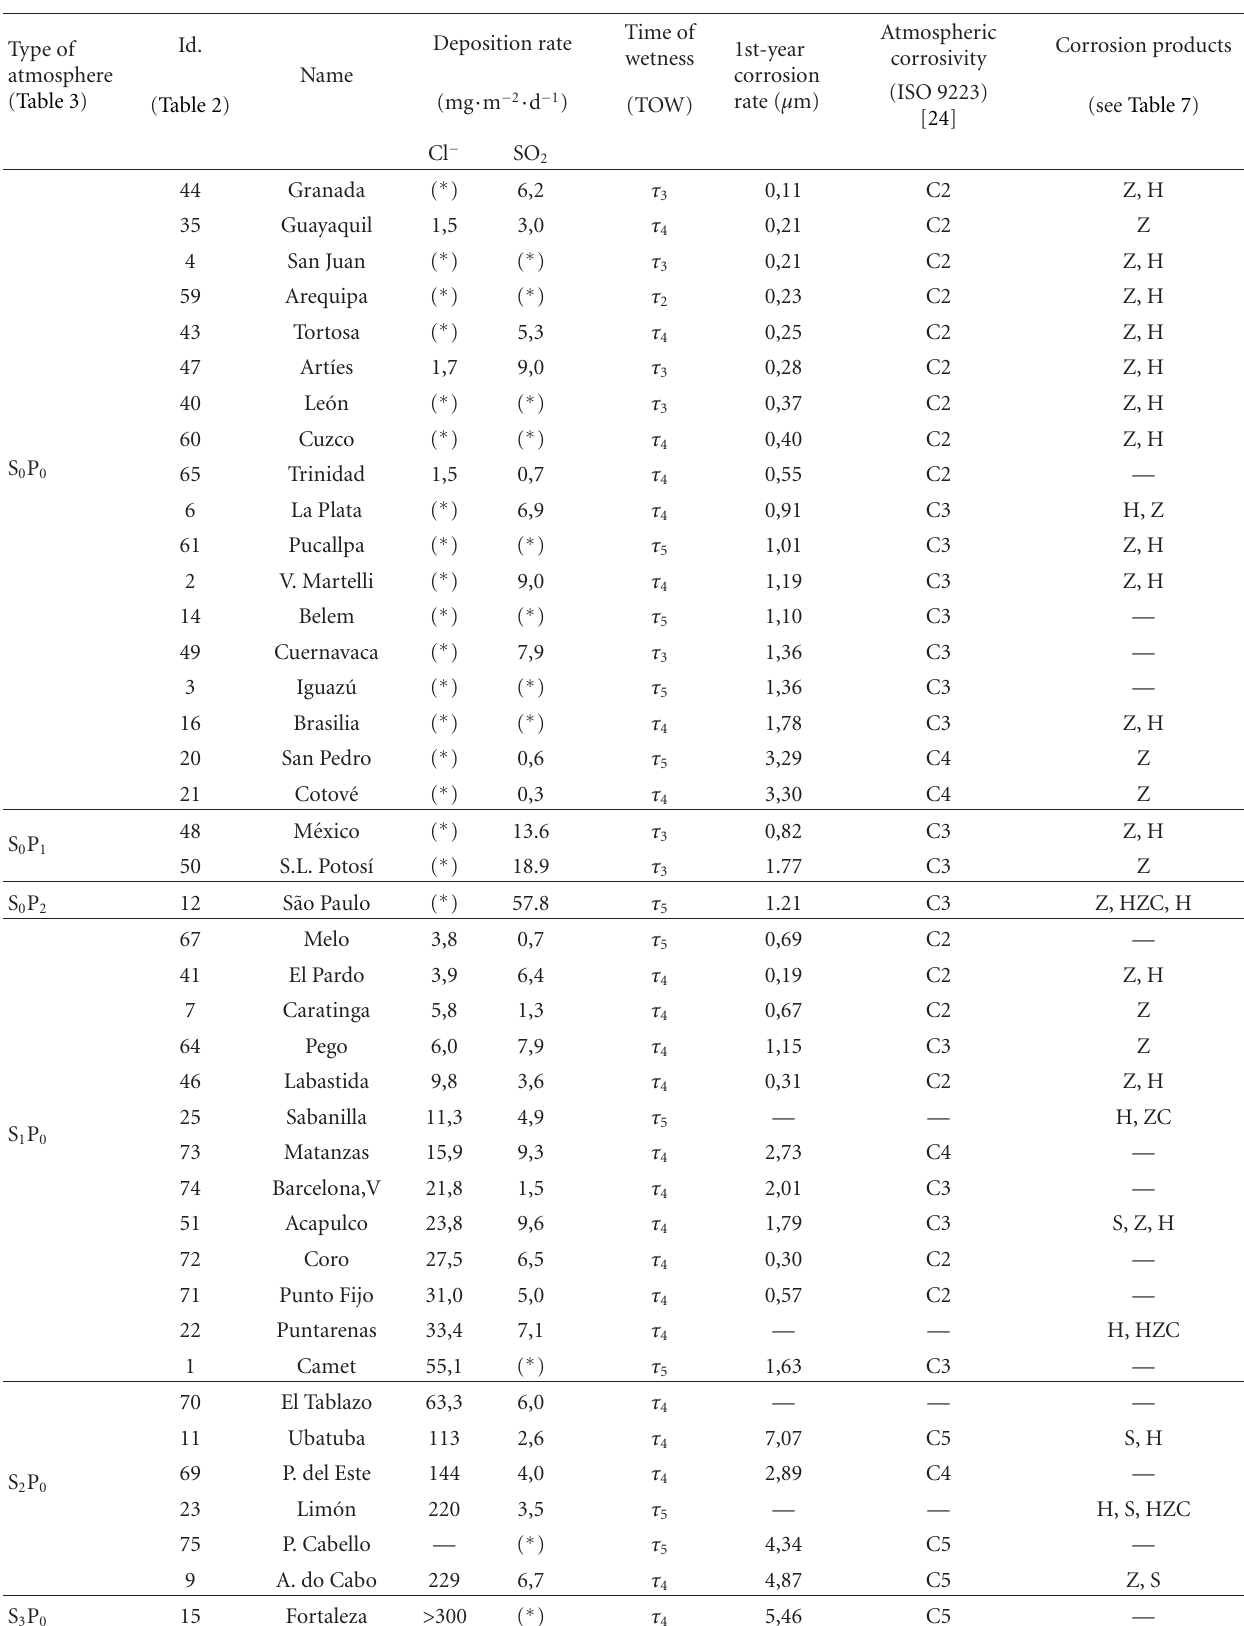
Table 6: MICAT test sites characteristics. Data for